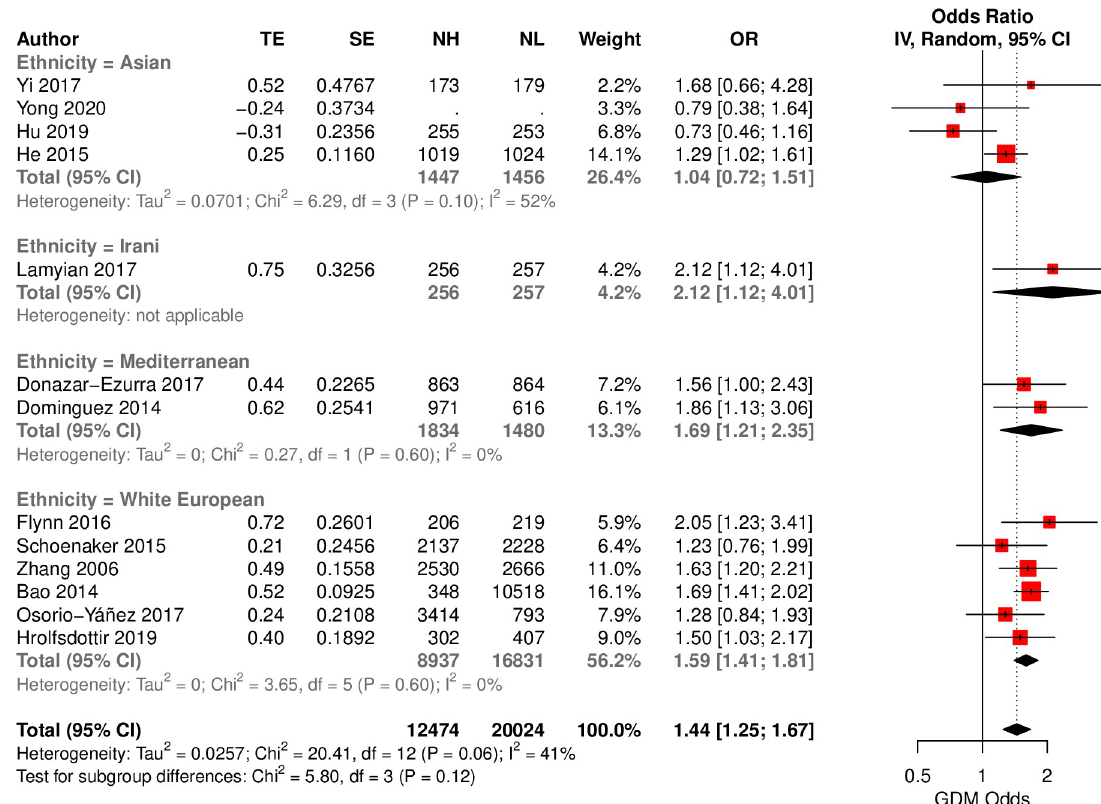
( Table E in S1 Text ). All analyses were adequately powered to detect a change in odds � 6% ( Table C in S1 Text ).